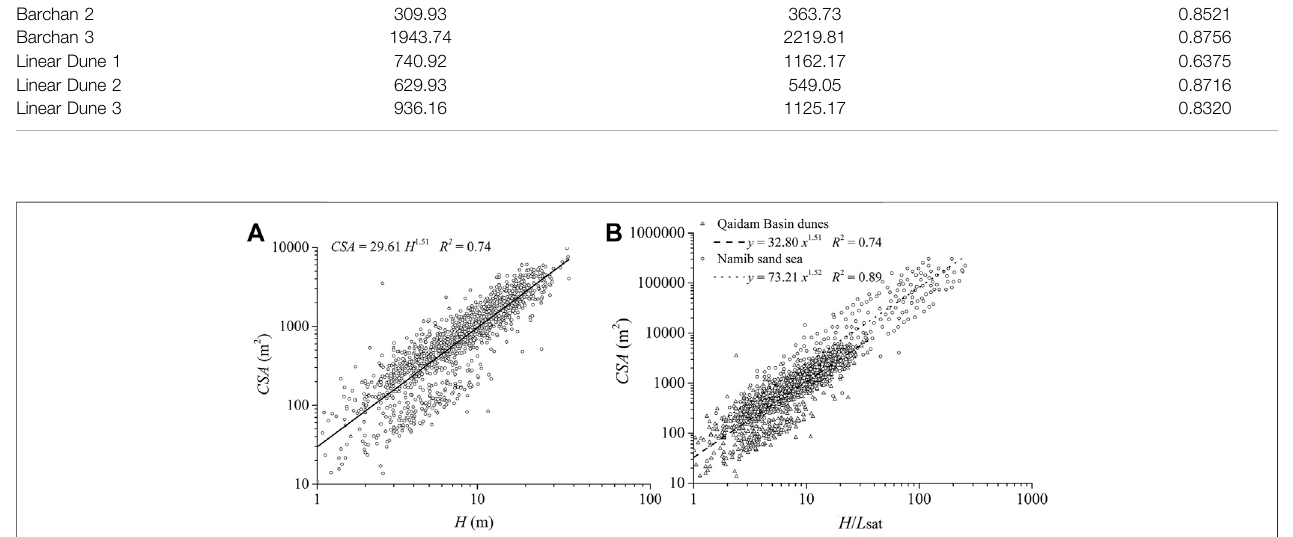
FIGURE 8 | (A) Relationship between individual dune height (H) and individual cross-sectional area ( CSA ) for the dune fi eld in the Qaidam Basin. (B) Relationship betweentherescaled individual duneheight( H/L sat ,where L sat represents thesaturatedlength) and thecross-sectionalarea( CSA )forthedune fi eld. DatafortheNamib sand sea were obtained from Bullard et al.